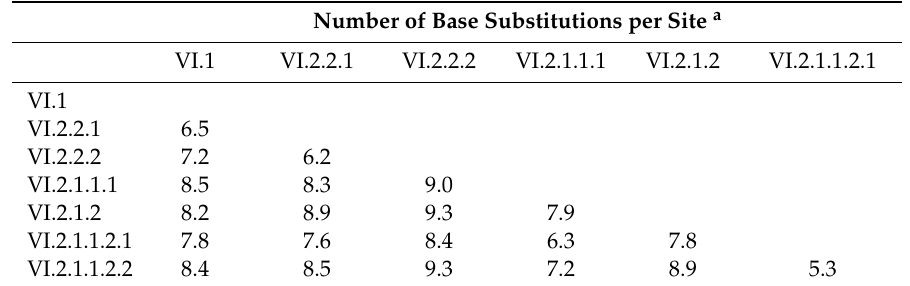
Table 2. Estimates of evolutionary distance between di ff erent sub-genotypes of class II genotype VI Newcastle disease viruses.